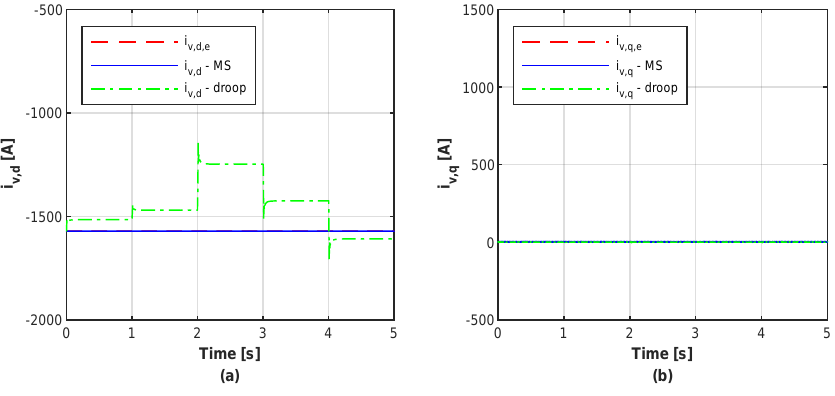
Figure 16. Output current response from terminal 3: ( a ) i v , d ; ( b ) i v , q